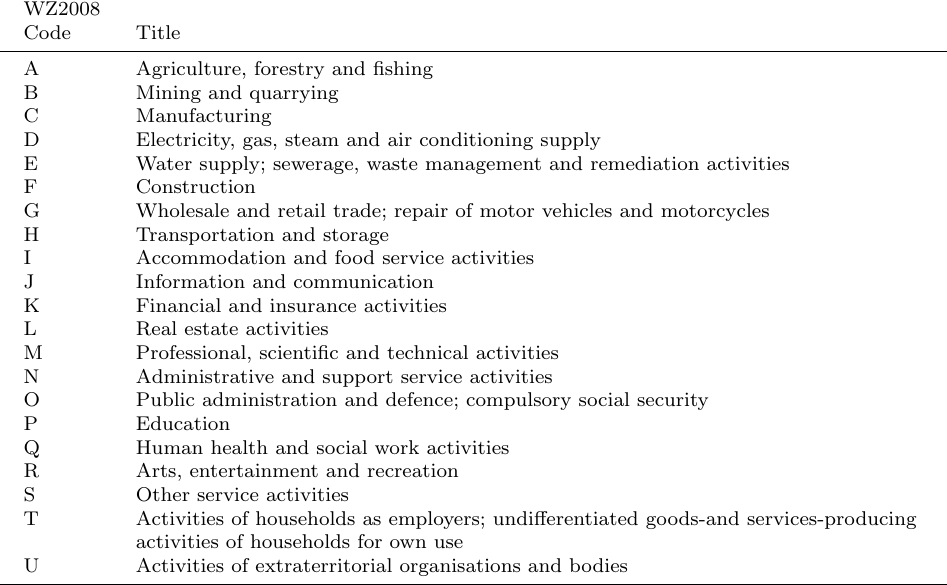
Table 9: Classification of economic activities in Germany, edition 2008 (WZ 2008) WZ2008